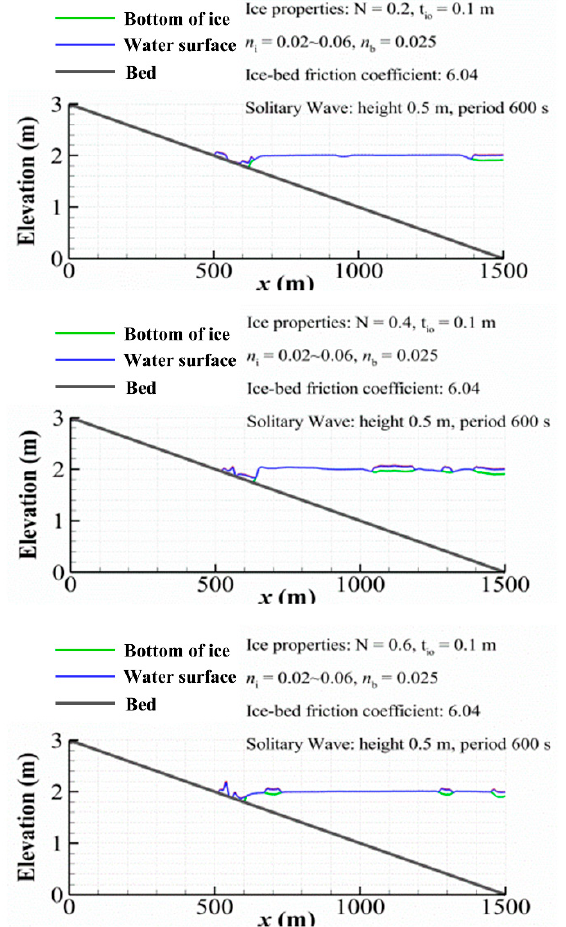
ff ect of ice concentration on ice deposition on the Figure 7. Effect of ice concentration on ice deposition on the beach . Figure 7. E Figure 7. Effect of ice concentration on ice deposition on the beach .